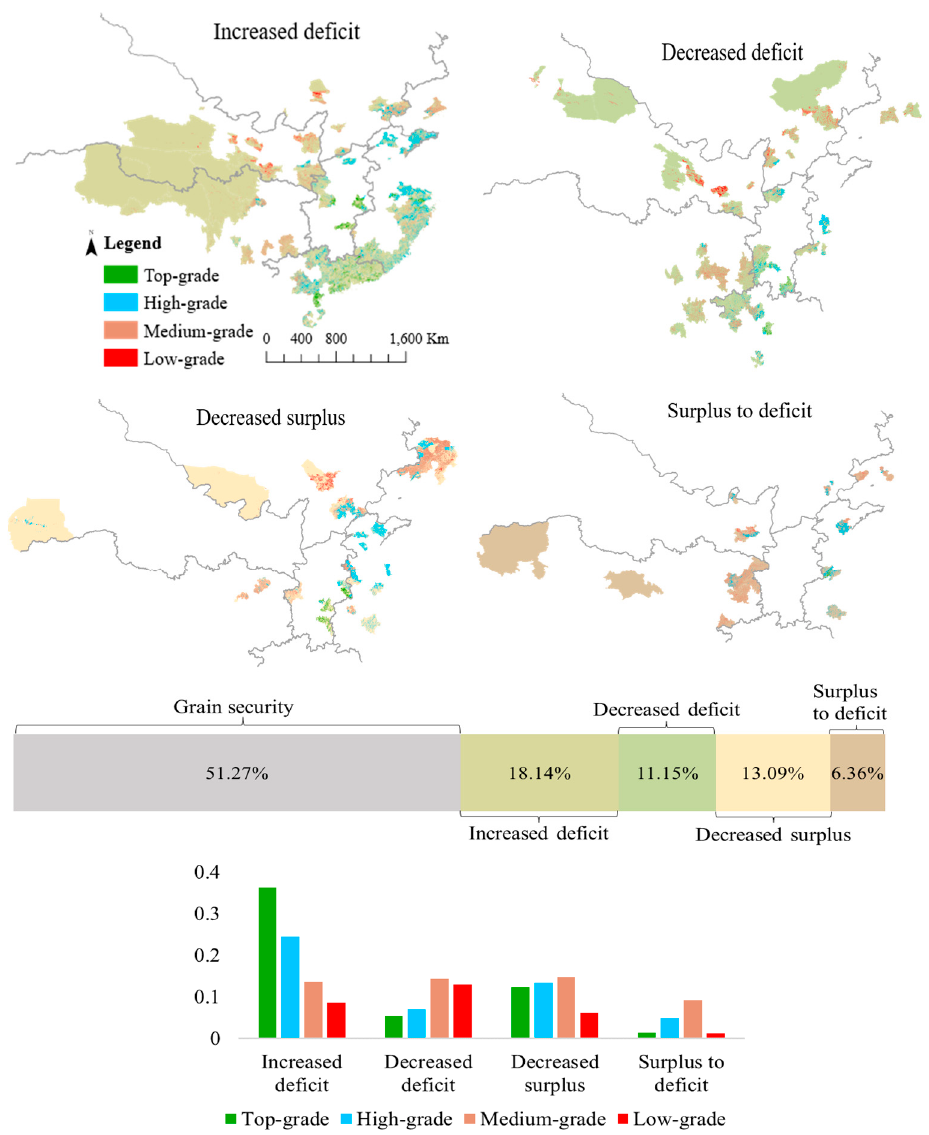
Figure 5. Spatial distribution of cultivated land varying with four types of grain insecurity. Where the colored bar below denotes the total proportion of cultivated land, the right bar chart denotes the proportion of cultivated land with top-grade, high-grade, medium-grade, and low-grade.